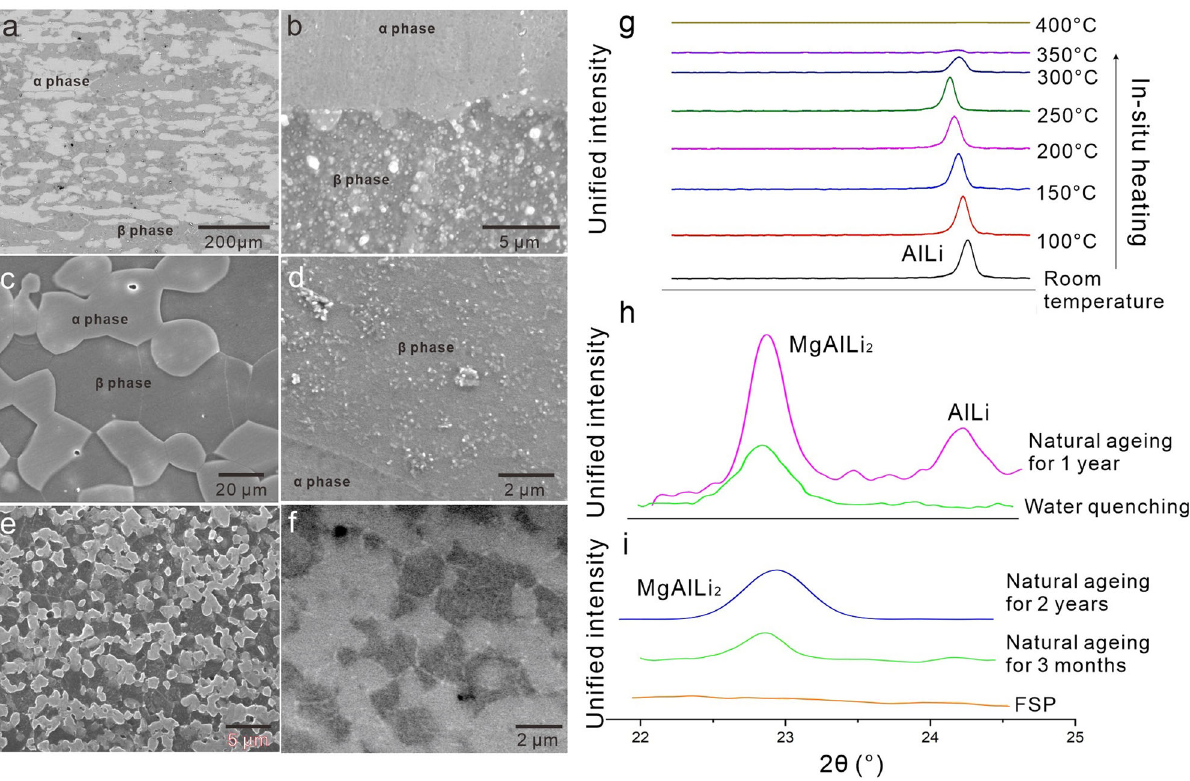
Fig. 4 SEM and XRD characterisation of microstructure evolution in natural ageing. a – f SEM images of samples at the states of ( a , b ) as-rolled, ( c ) WQ, ( d ) WQ-aged for 1 year, ( e ) FSP and ( f ) FSP-aged for 2 years. g – i XRD θ -2 θ scan between 22° and 25° showing the AlLi (111) peak and MgAlLi 2 (111) peak during ( g ) in situ heating, ( h ) WQ and natural ageing for 1 year, and ( i ) FSP and natural ageing up to 2